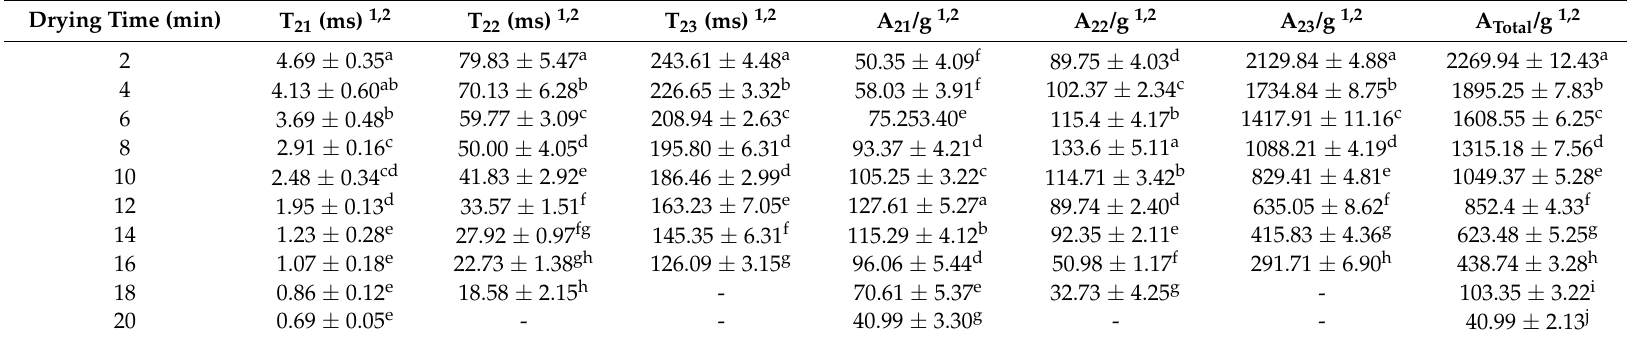
Table 3. Changes in relaxation time and peak area of G. elata dried at 60 ◦ C after